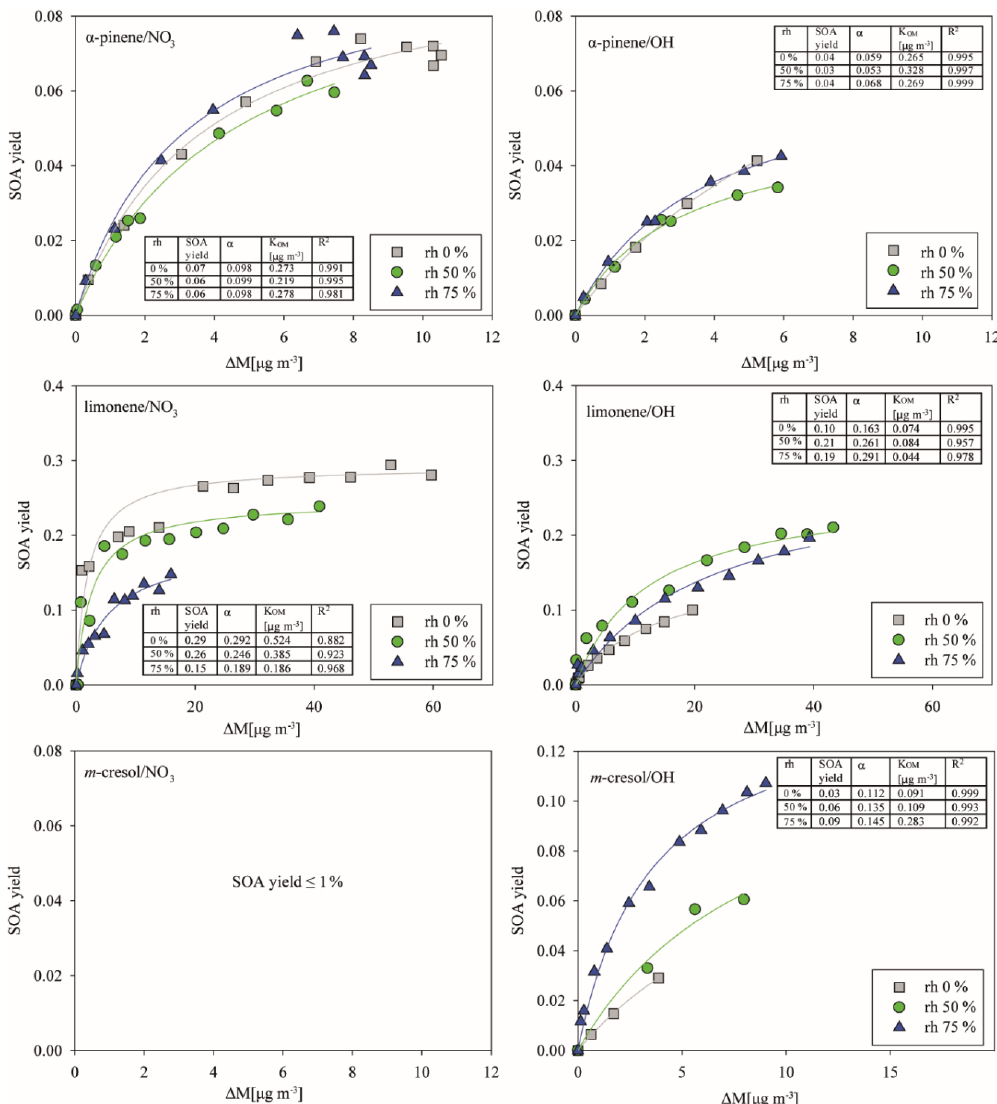
Figure 1. Yield curves for α -pinene, limonene, and m -cresol with NO 3 and OH radicals for 0, 50, and 75% RH. Yield curves were param- eterized with the one-product approach (Odum et al., 1996). The obtained values for α (mass yield) and K OM (partitioning coefficient) are included as well. Please note that the SOA yield of m -cresol / NO 3 was below 0.01%. Therefore, no parameterization can be provided. Each fit presents a single chamber experiment. SOA yield was calculated by deviating the produced organic mass by the consumed amount of